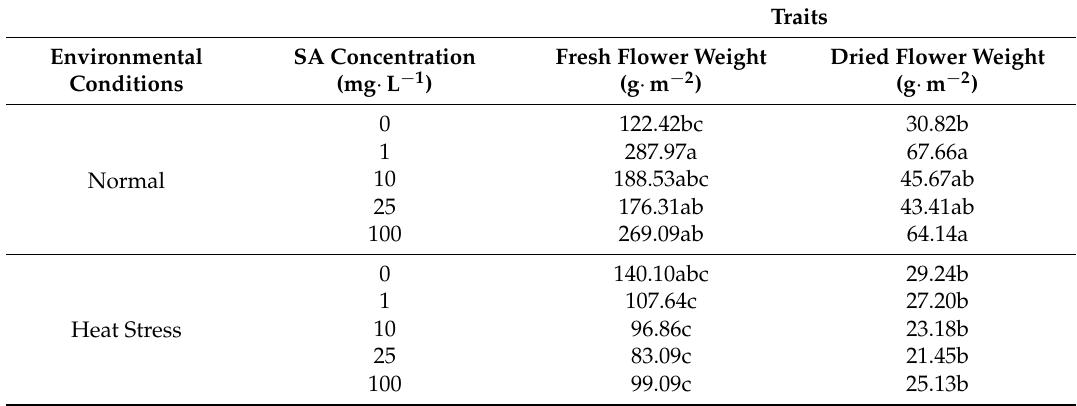
Table 9. Mean comparison for the interaction between environmental conditions and salicylic acid on studied traits of